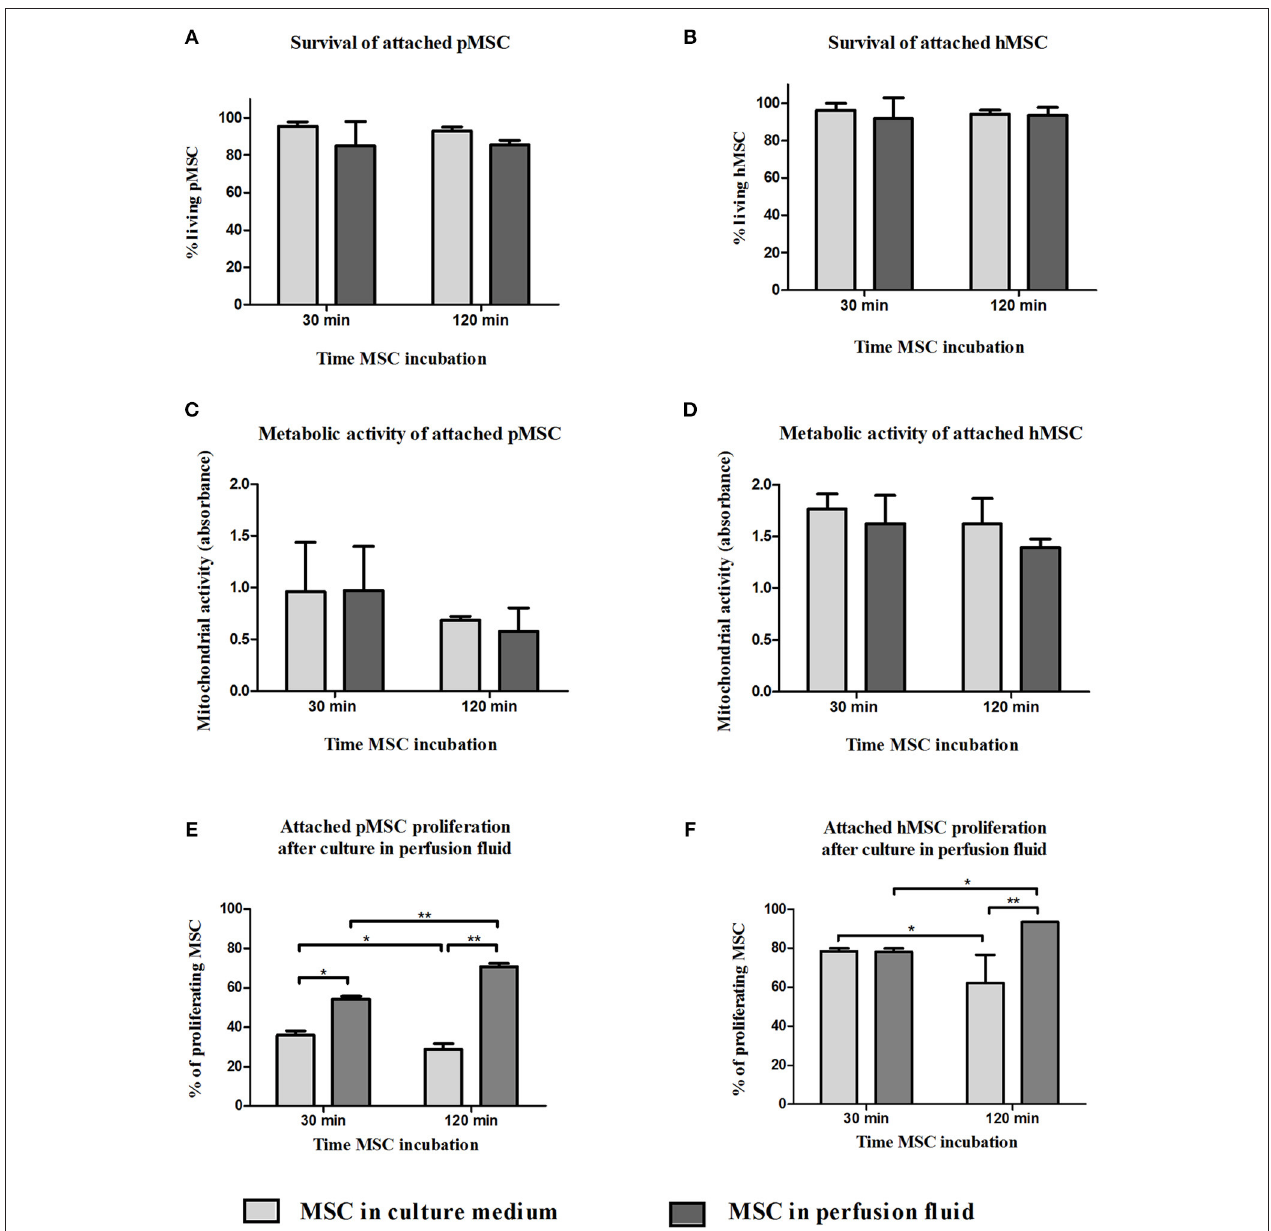
FIGURE 6 | Effect of perfusion fluid on attached MSC. Survival of attached pMSC (A) and hMSC (B) after 30min in perfusion fluid. (C,D) Metabolic activity of attached pMSC (C) and hMSC (D) after 30min in perfusion fluid measured by reduction of XTT. (E,F) Proliferation of attached pMSC (E) and hMSC (F) after 30 in perfusion fluid. Cells were trypsinized and re-seeded in a culture flask. Proliferation after 24h was determined by CFSE fluorescence ( n = 5). Results are shown as means ± SD. * p < 0.05; ** p <